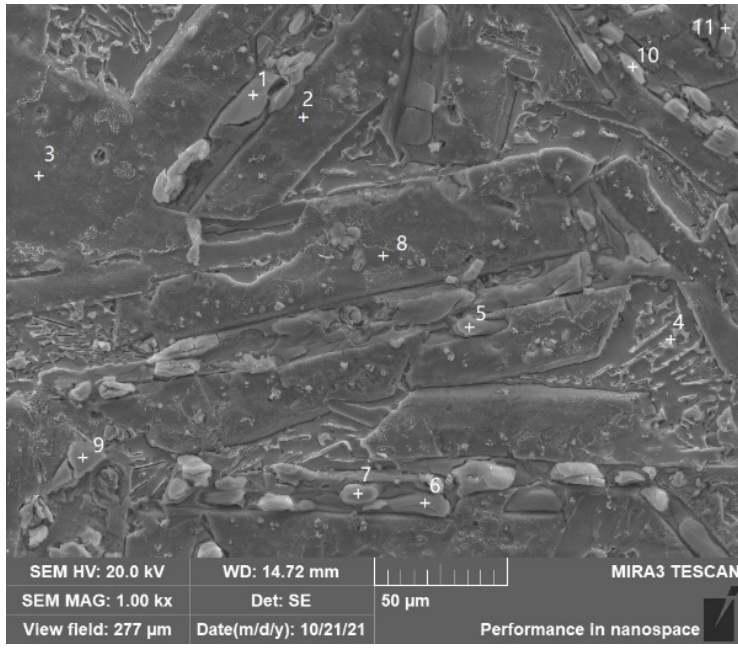
Figure 9. The SEM image of the as-cast Mg 30 Zn 30 Sn 30 Sr 5 Bi 5 alloy.